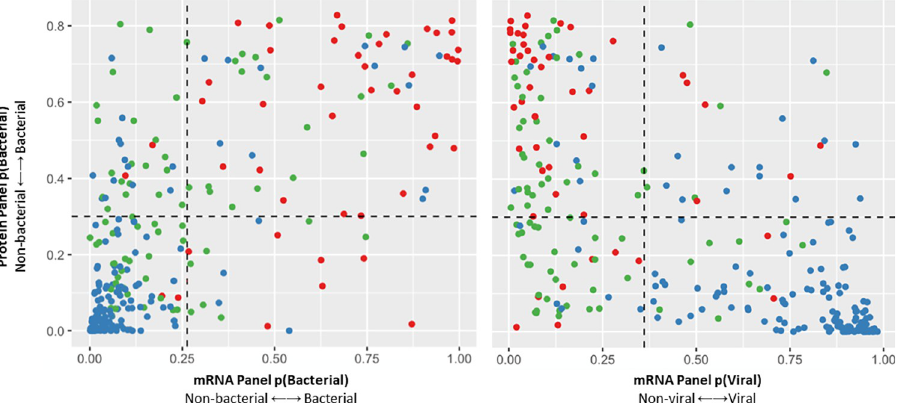
Fig 4. Distribution of predicted bacterial (left) and viral (right) infection probabilities using the protein and mRNA panels. The probabilities predicted by the protein panel test (y-axis) are plotted relative to the probabilities predicted by the mRNA panel test (x-axis). The dashed horizontal line corresponds to the optimal protein panel threshold. The vertical line corresponds to the optimal mRNA panel threshold. Bacterial infection cases are represented by red dots. Viral infection cases are represented by blue circles. Non-infectious illness cases are represented by green